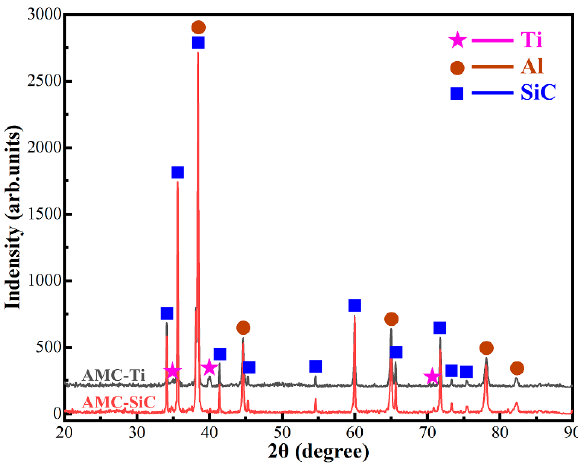
Figure 7. XRD patterns of the prepared composites.